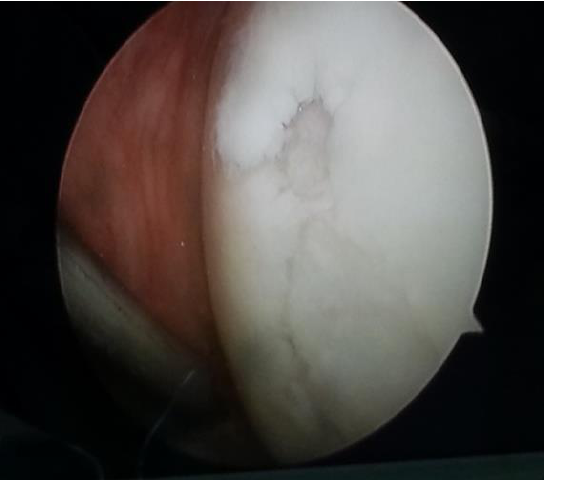
Figure-3-Arthroscopic view of cartilagenuos lesion